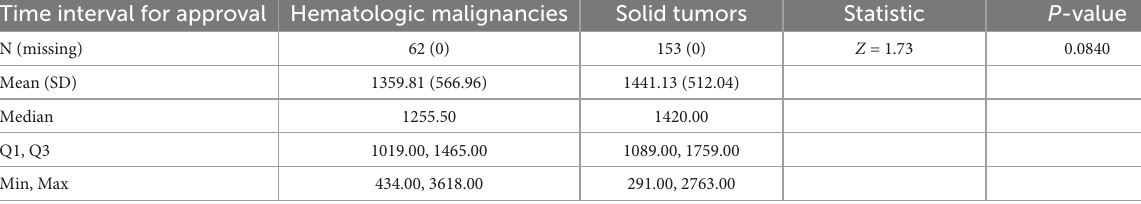
TABLE 11 Time interval for approval between different drug types.